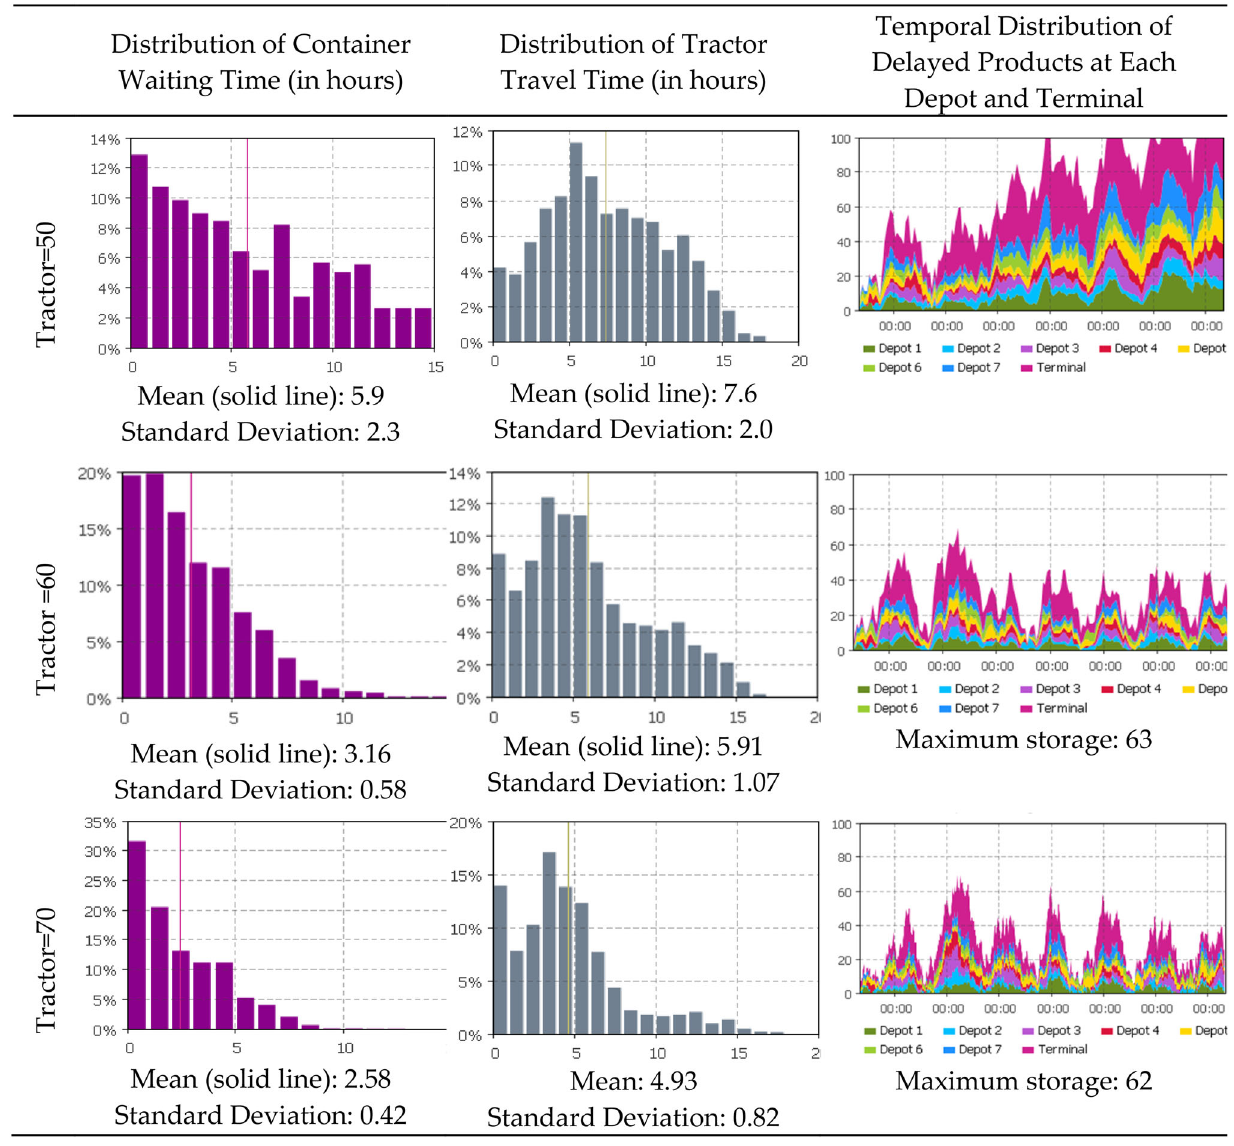
Fig. 6 Impact of fleet size options on freight